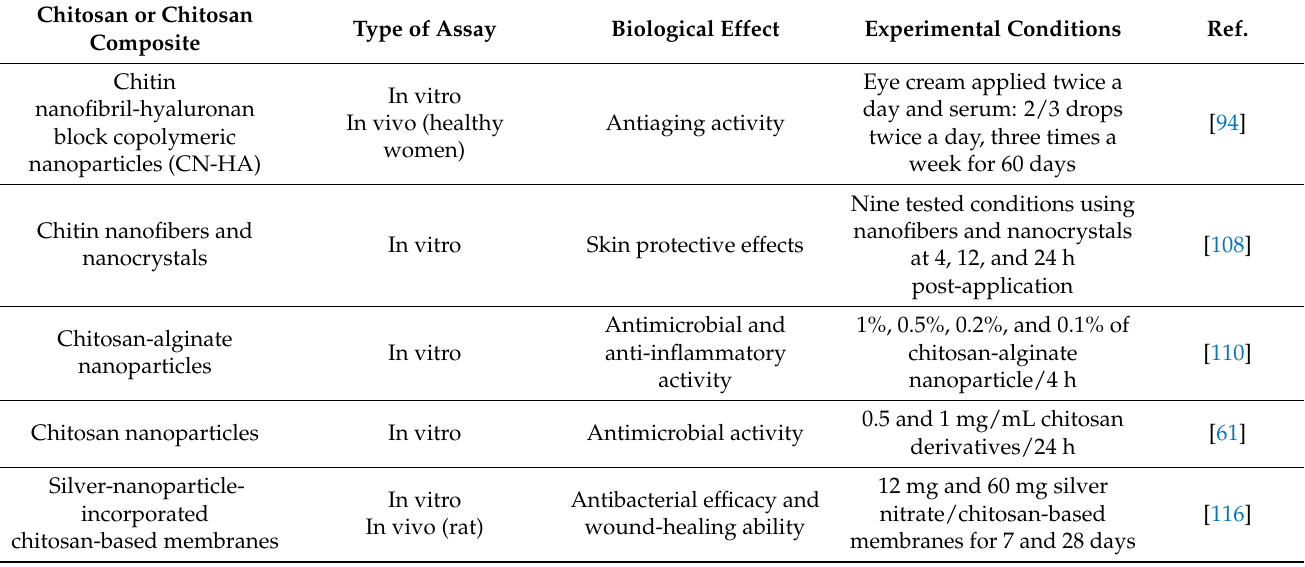
Table 1. Studies on chitosan formulations for skin protection and cosmeceutical